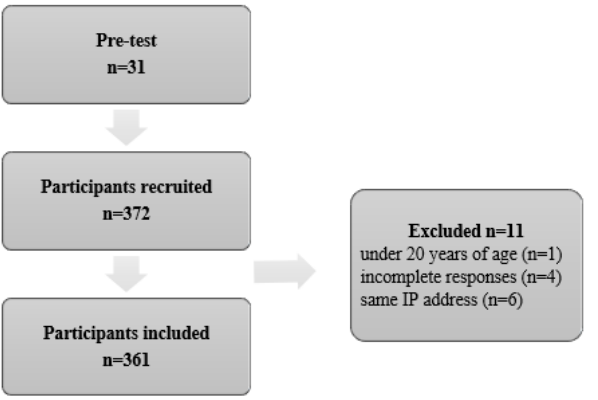
Figure 1. Flow chart of the study design and screening